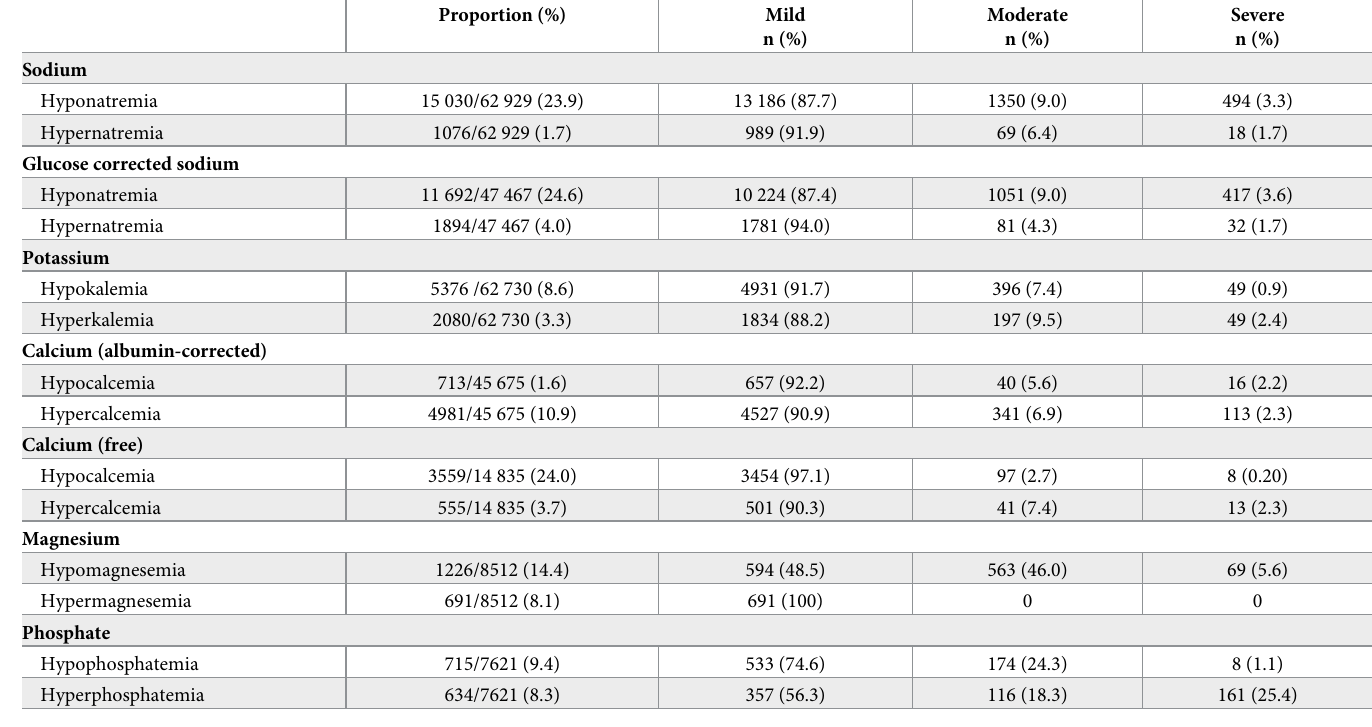
Table 2. Electrolyte imbalance frequency by degree of severity for all ED visits 2010–2015.